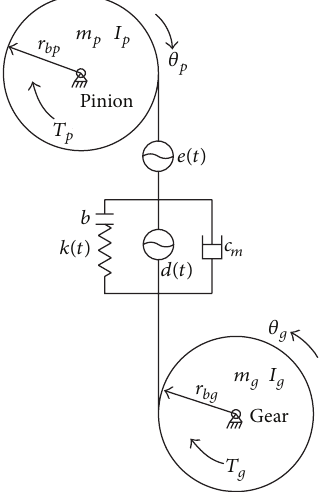
Figure 2: The nonlinear dynamic model of the two gears